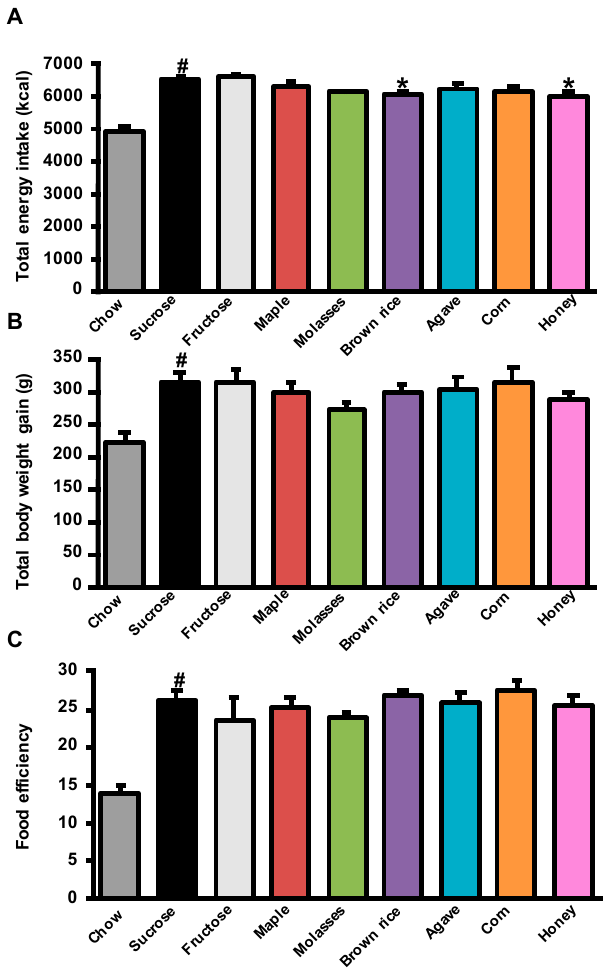
Figure 1. Refined sugars and natural sweeteners lead to similar obesity. Energy intake, body weight gain, and food efficiency in Wistar male rats treated with refined sugars and natural sweeteners for 8 weeks. ( A ) Total energy intake; ( B ) total body weight gain; ( C ) food efficiency. Data represent mean ± SEM, n = 10–12 rats. # p < 0.05, t -test for chow-sucrose (reference for high fat high sucrose (HFHS)-induced obesity) versus HFHS-sucrose. * p < 0.05, one-way ANOVA for fructose and natural sweeteners versus HFHS-sucrose. Table 1. Effects of refined sugars and natural sweeteners on body and organs weights. Body (g) Liver (g) Pancreas (g) iWAT (g) eWAT (g) BAT